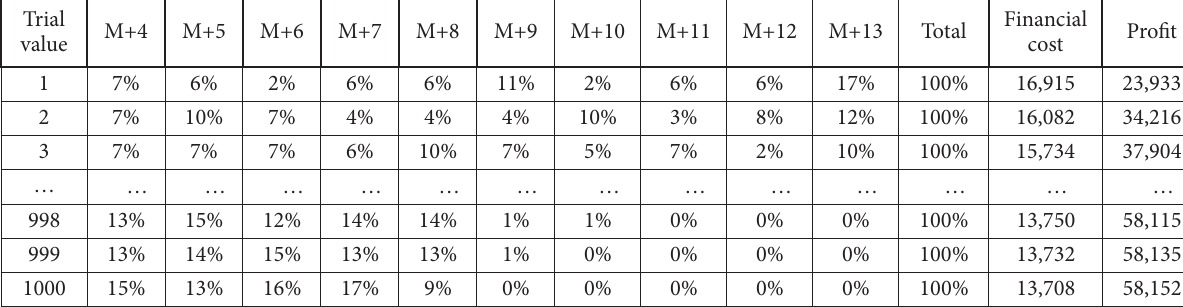
Figure 12. Simulation result at t 3 Table 5. Results of simulation at t 3 (Unit: 1,000